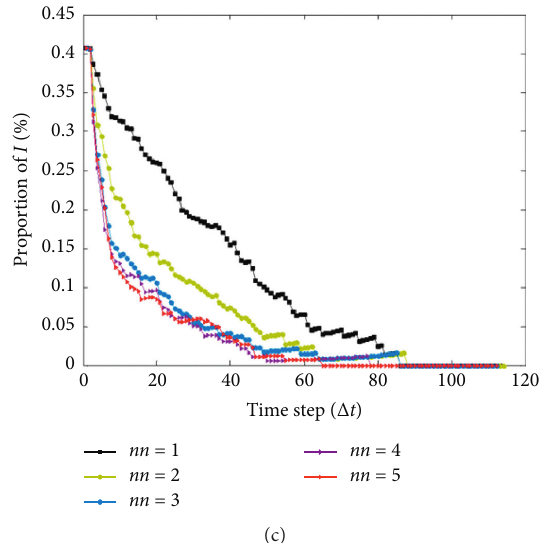
� 0 . 4. (b) λ � 0 . 5. emotion emotion